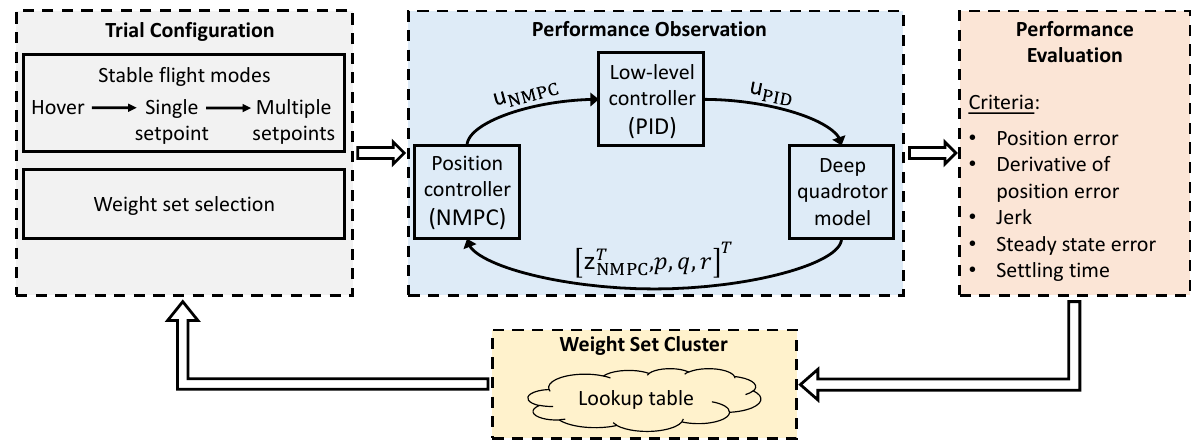
Figure 2. Proposed (N)MPC weight tuning framework. Throughout the tuning process, each trial starts with the Trial Configuration module. Weight set selection and Stable flight mode submodules give necessary instructions to (N)MPC. Taking these as inputs, (N)MPC controls the quadrotor model while its performance is being observed simultaneously. Once a flight is completed, the performance of the (N)MPC with the utilized weight set is graded based on the five criteria. Subsequently, the trial is finalized by updating the weight set cluster. Thereafter, a new trial begins with the selection of a new weight set within the Trial Configuration module, and thus closes the